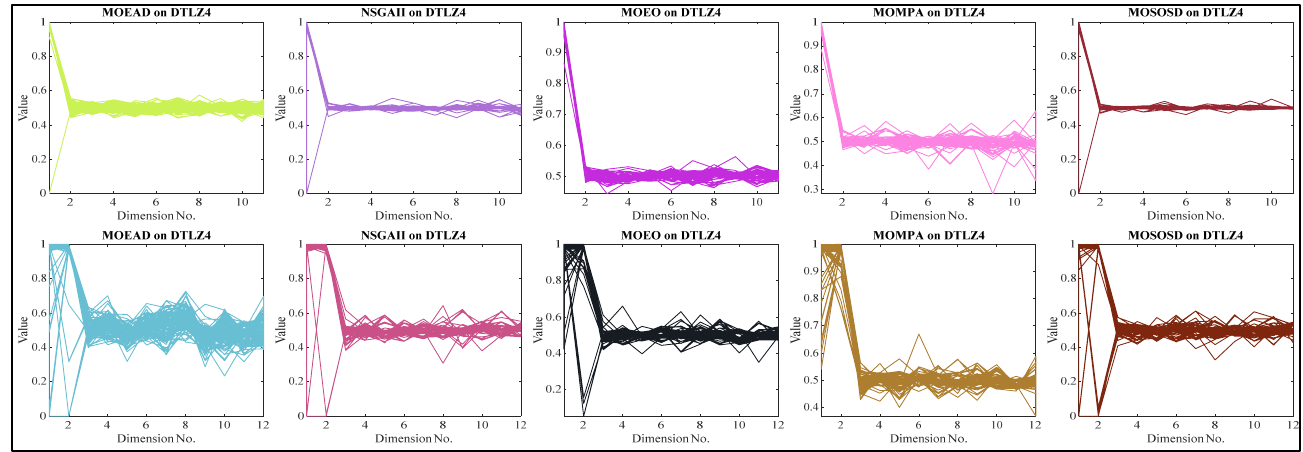
Figure 12. The dimension curve of MOEA/D, NSGA-II, MOEO, MOMPA, and MOSOS/D for DTLZ4 at M = 2, 3.